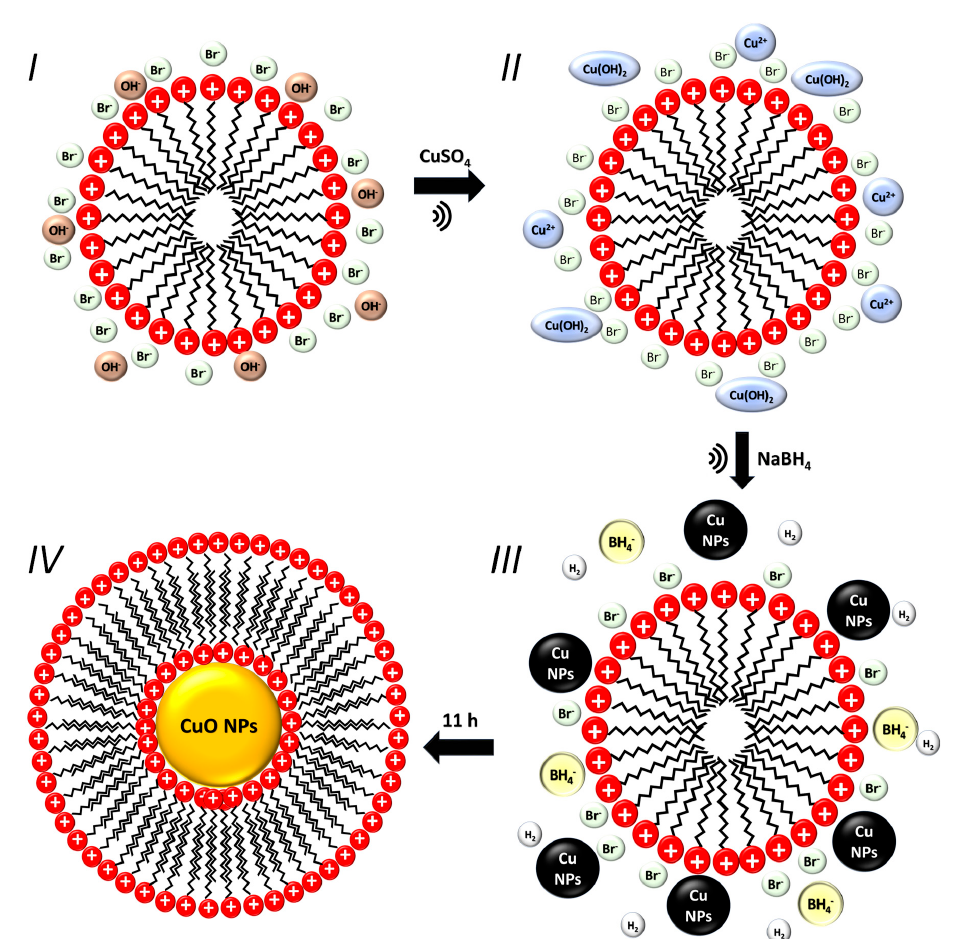
Figure 4. Schematic representation of the synthesis mechanism of CuO NPs obtained by